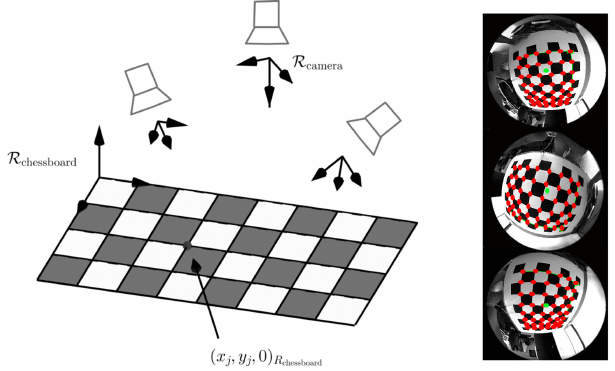
Figure 4. Calibration procedure by multiple views of the same chessboard. The procedure is automatized by using an algorithmic corner detection. The camera projection function is estimated with the OcamCalib toolbox following Scaramuzza et al. (2006) mod-